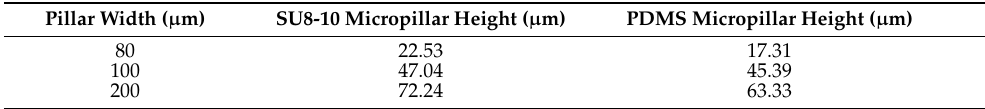
Table 1. SU8 micropillar mold; PDMS micropillar measured by surface